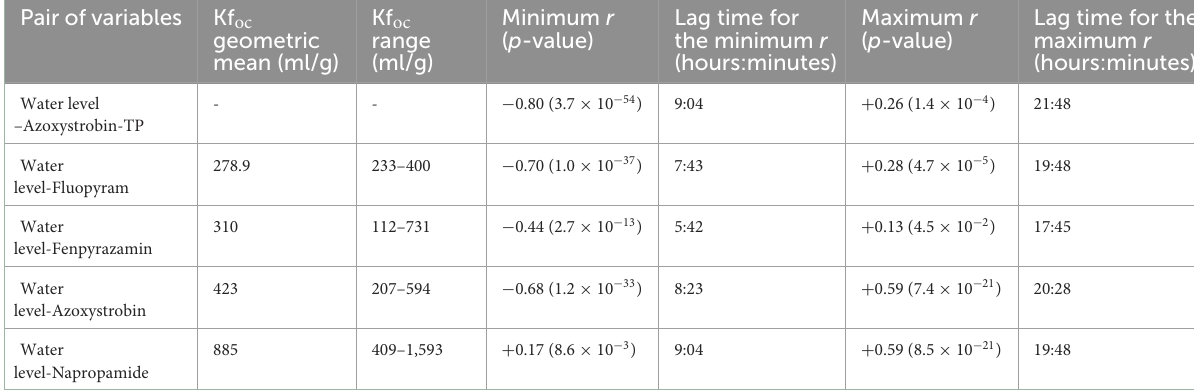
TABLE 4 Correlations between time series of water level and compounds that showed diel concentrations fluctuations during the second dry period. Pair of variables